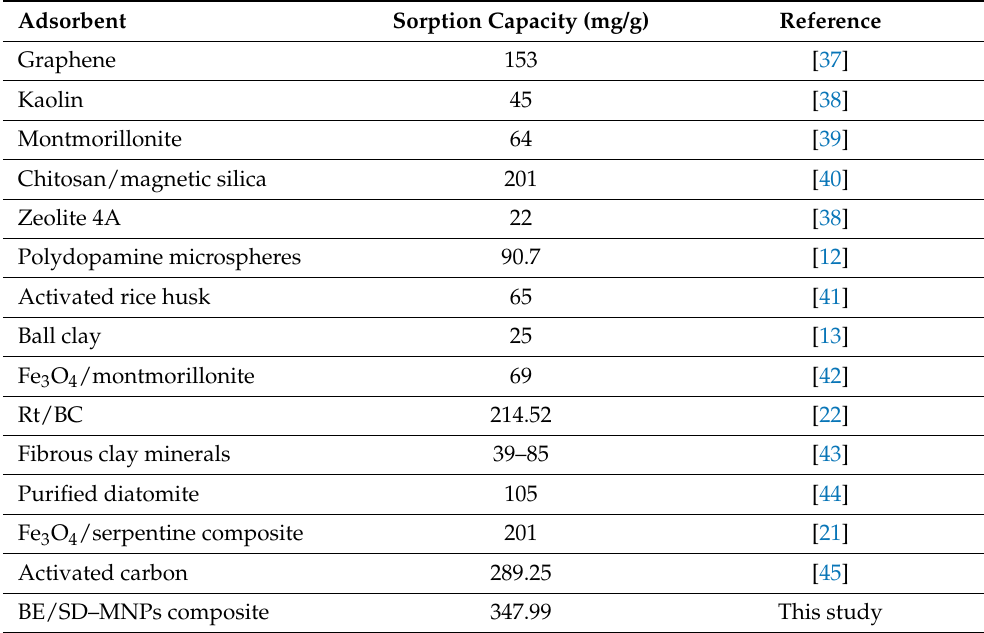
Table 3. MB adsorption capacities of the BE/SD–MNPs composite and different adsorbents.